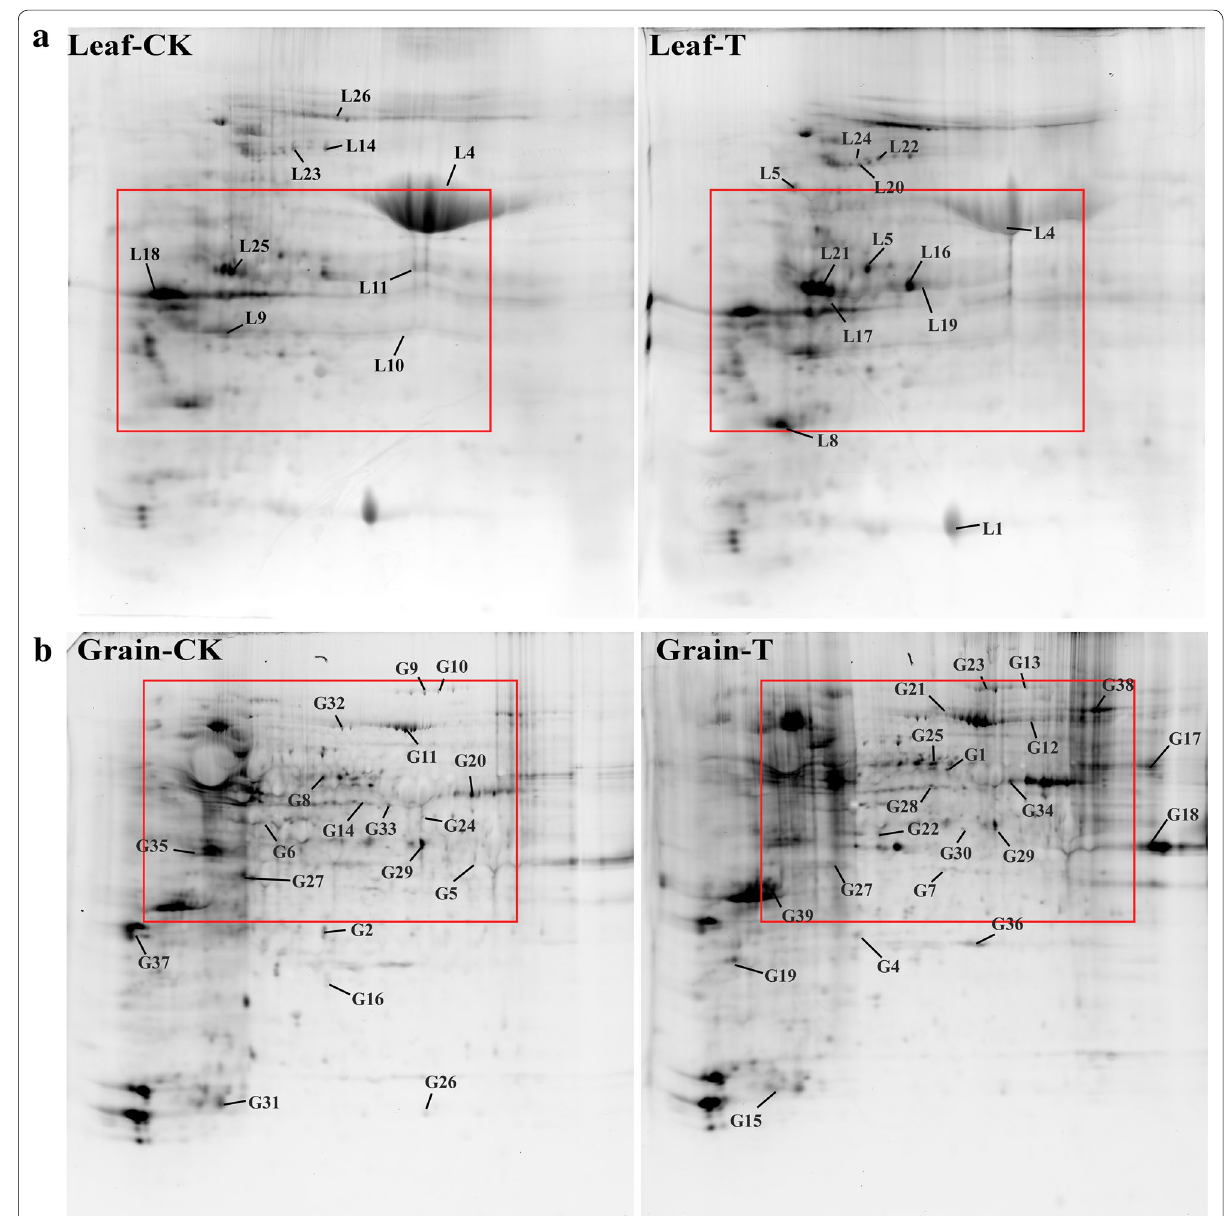
Fig. 5 Detection of phosphorylated proteins in 2-DE gels by Pro-Q diamond staining. a The image of Pro-Q diamond staining in flag leaves. b The image of Pro-Q diamond staining in